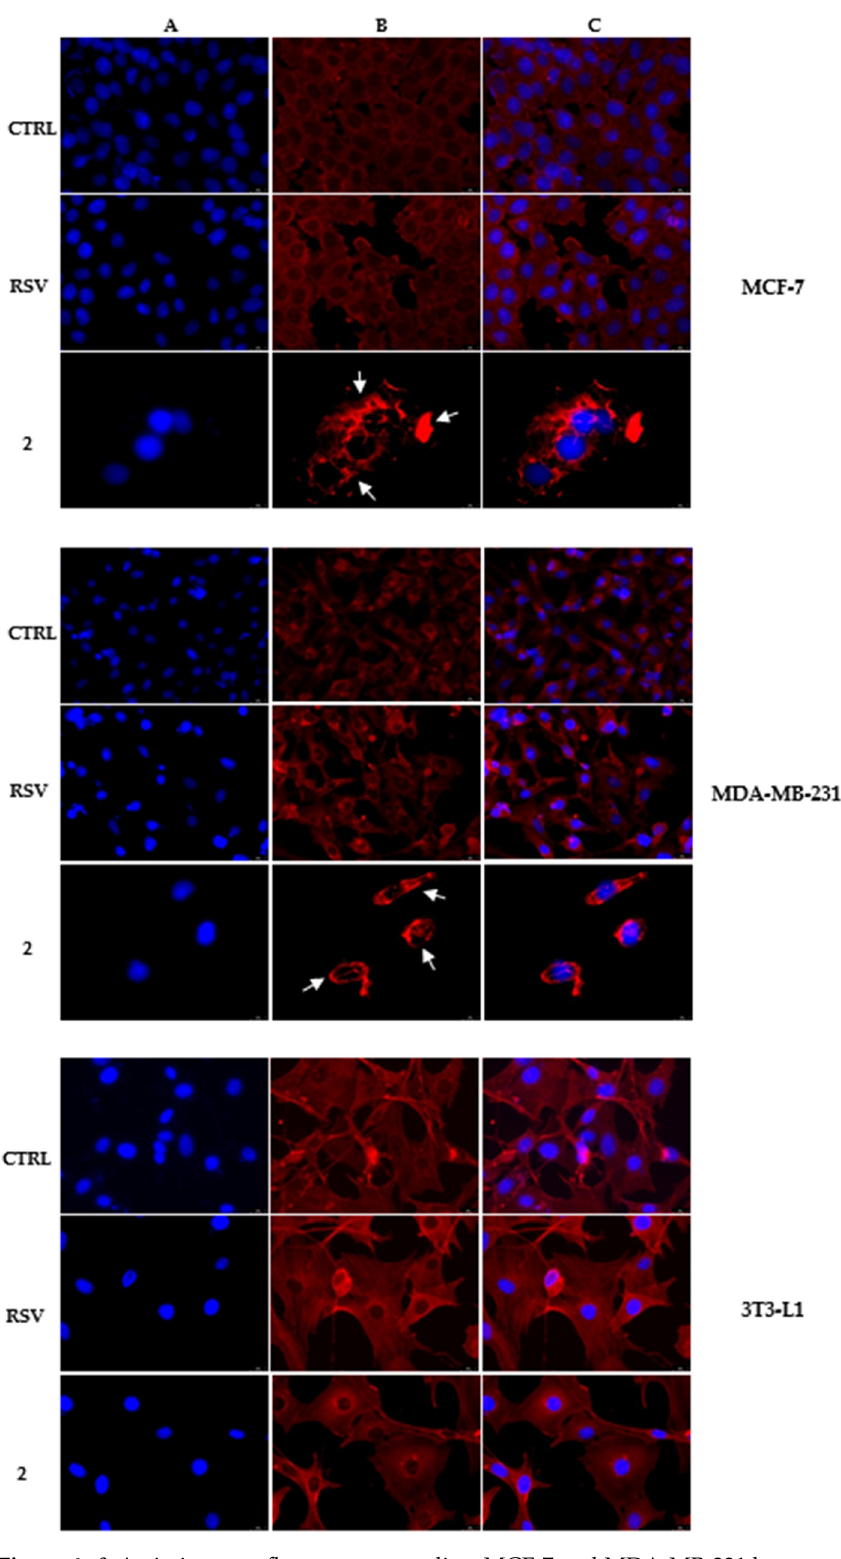
Figure 6. β -Actin immunofluorescence studies. MCF-7 and MDA-MB-231 breast cancer cells and 3T3-L1 cells were exposed to the derivative 2 (25 µ M), RSV (25 µ M), or with the vehicle (CTRL, DMSO) for 24 h. CTRL cells and RSV-treated cells showed a normal organization of the actin filaments within the cell cytoplasm; 3T3-L1 cells treated with the derivative 2 also showed a normal arrangement of the actin system; contrarily, both the breast cancer cells exposed to the derivative 2 exhibited a strong disorganization of the actin system. Cells were monitored using the inverted